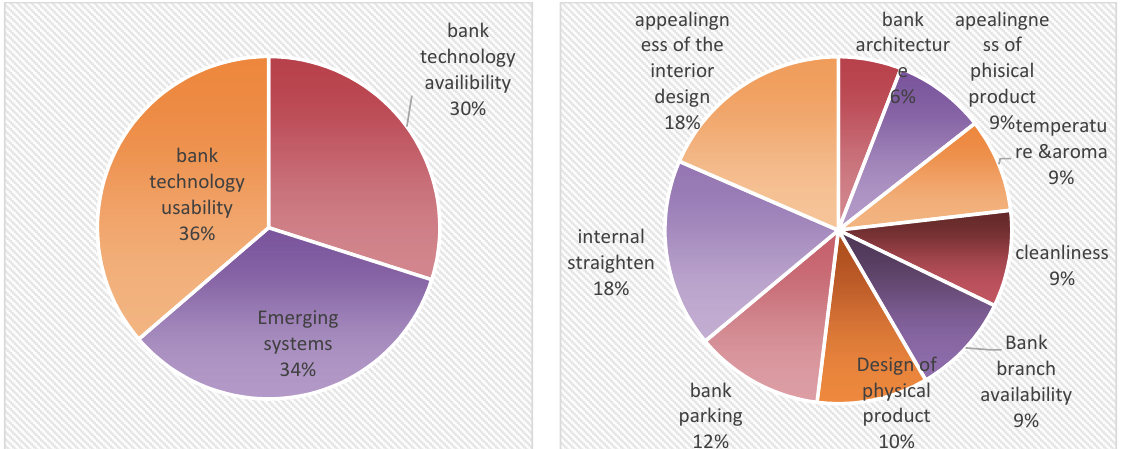
Fig. 5. Weight of the sub-factor of technology Fig. 6. Weight of the sub-factor of bank